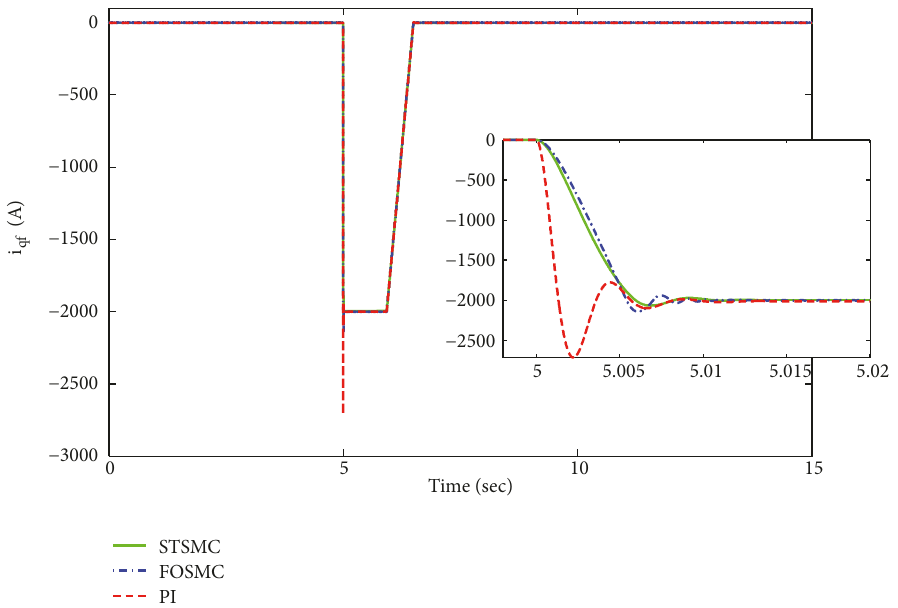
Figure 8: The q-axis current of the GSC with PI, FOSMC, and STSMC.